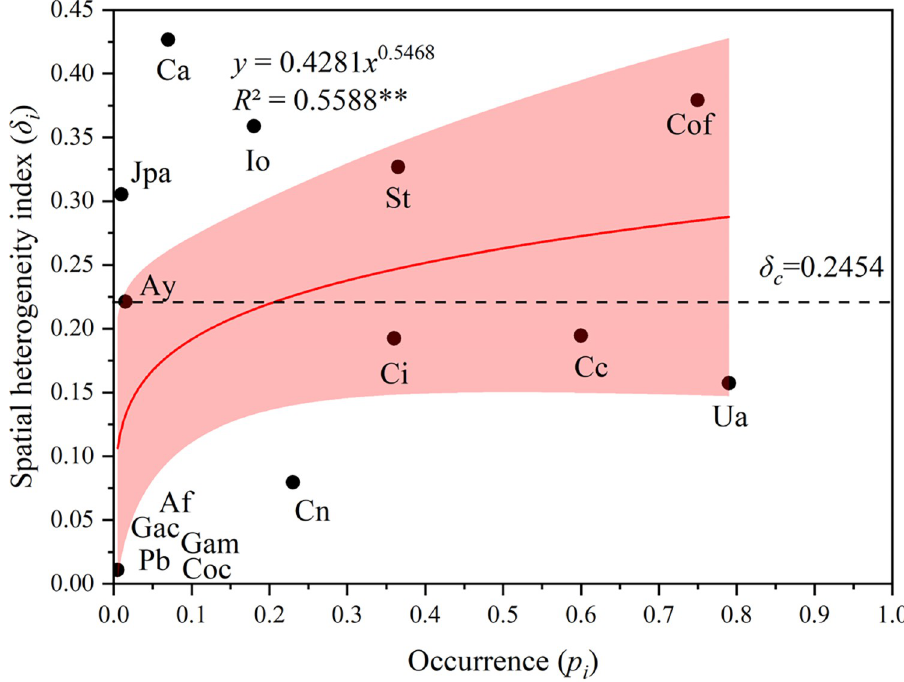
Fig 4. The relationship between occurrence and spatial heterogeneity index. �� was significantly correlated (p < 0.01). The line of best fit (red line) was generated with 95% confidence intervals (pink area). Individual macroalgae species (black dots) were plotted (abbreviations defined below). The overall spatial heterogeneity index of the seaweed community (dotted line) was calculated ( δ 0.2454). Species (black dot) abbreviations: Callophyllis c = adnata (Ca), Corallina officinalis (Cof), Ishige okamurae (Io), Sargassum thunbergia (St), Jania pedunculata var. adhaerens (Jpa), Alatocladia yessoensis (Ay), Chondria crassicaulis (Cc), Chondracanthus intermedius (Ci), Ulva australis (Ua), Chondrus nipponicus (Cn), Grateloupia acuminata (Gac), Chondrus ocellatus , (Coc) Ahnfeltiopsis flabelliformis (Af), Gelidium amansii (Gam), Petalonia binghamiae (Pb).